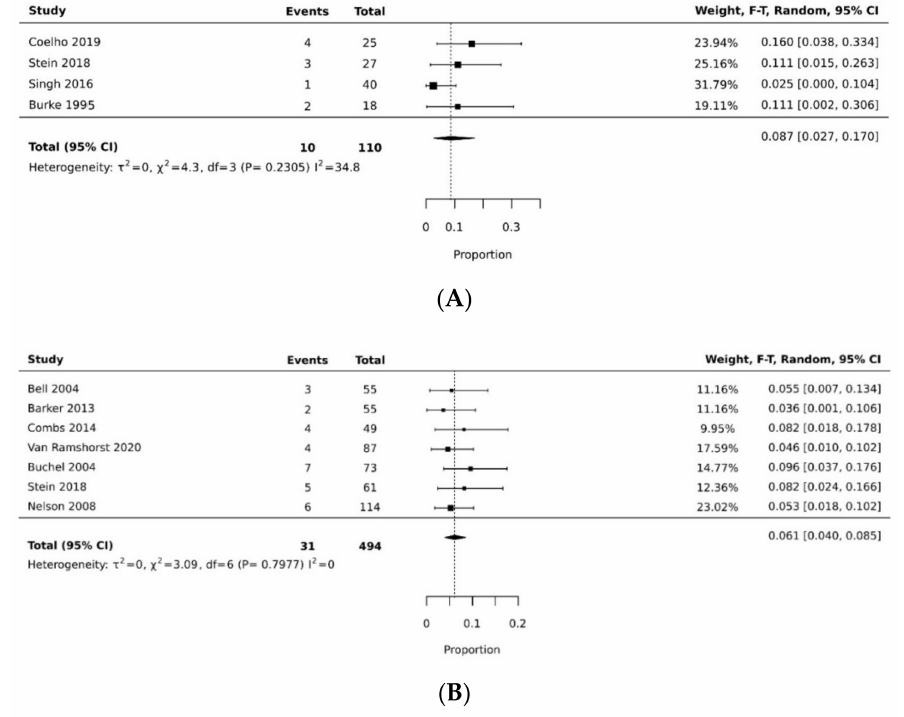
Figure 8. ( A ) Forest plot for partial flap necrosis for gracilis [21,26,36,38]. ( B ) Forest plot for partial flap necrosis for VRAM [11,12,26–29,34].